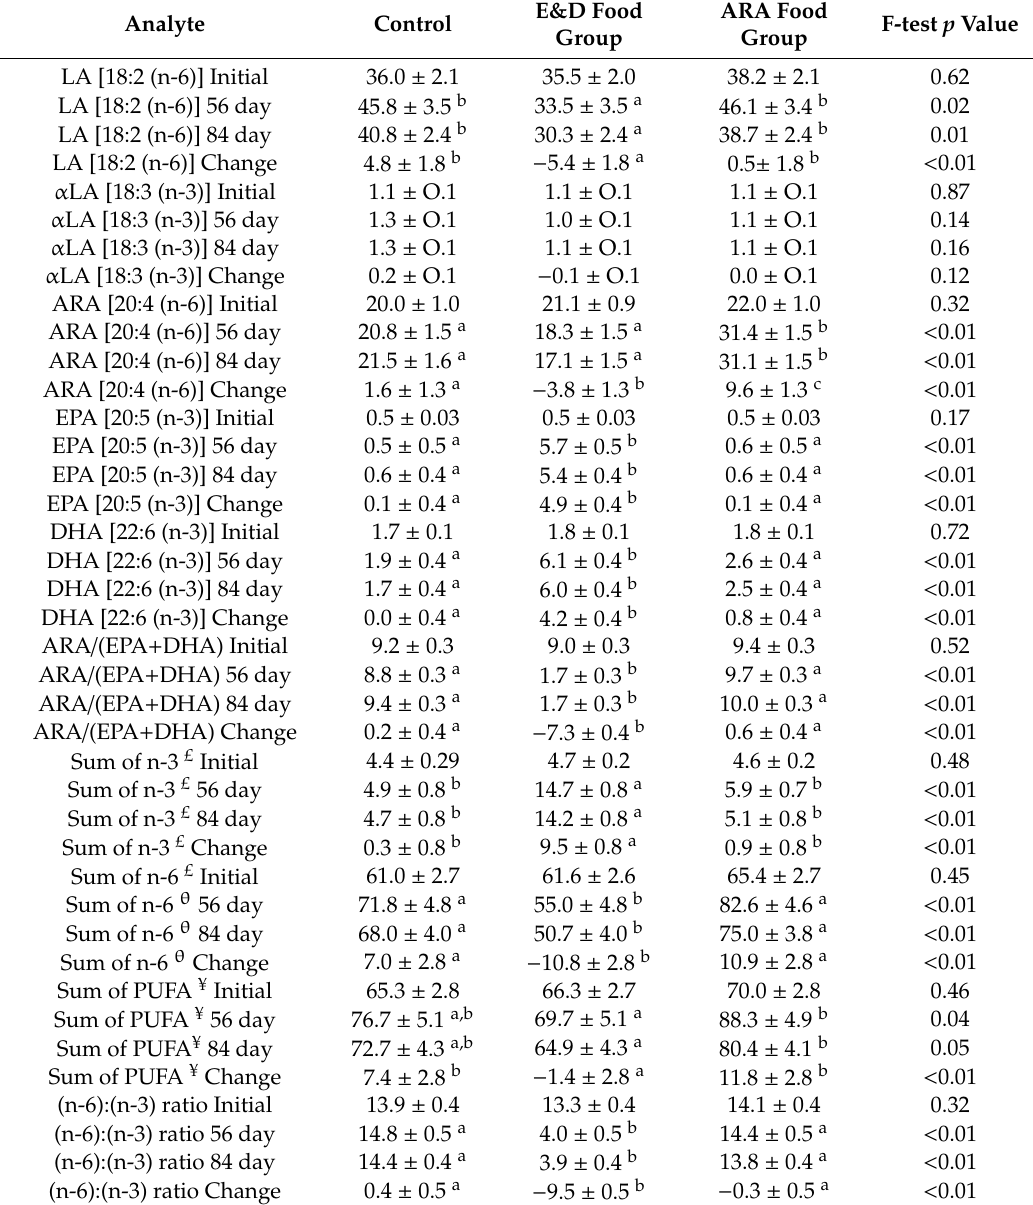
Table 3. Circulating concentration (mg / dL) of polyunsaturated fatty from cats eating control food (COF), or test food 1 (E&DF) COF enhanced with EPA and DHA from fish oil, or test food 2 (ARAF) COF enhanced with arachidonic acid from chicken liver, at initial, 56 days, 84 days of test and change during the study (values are lsmeans ± standard